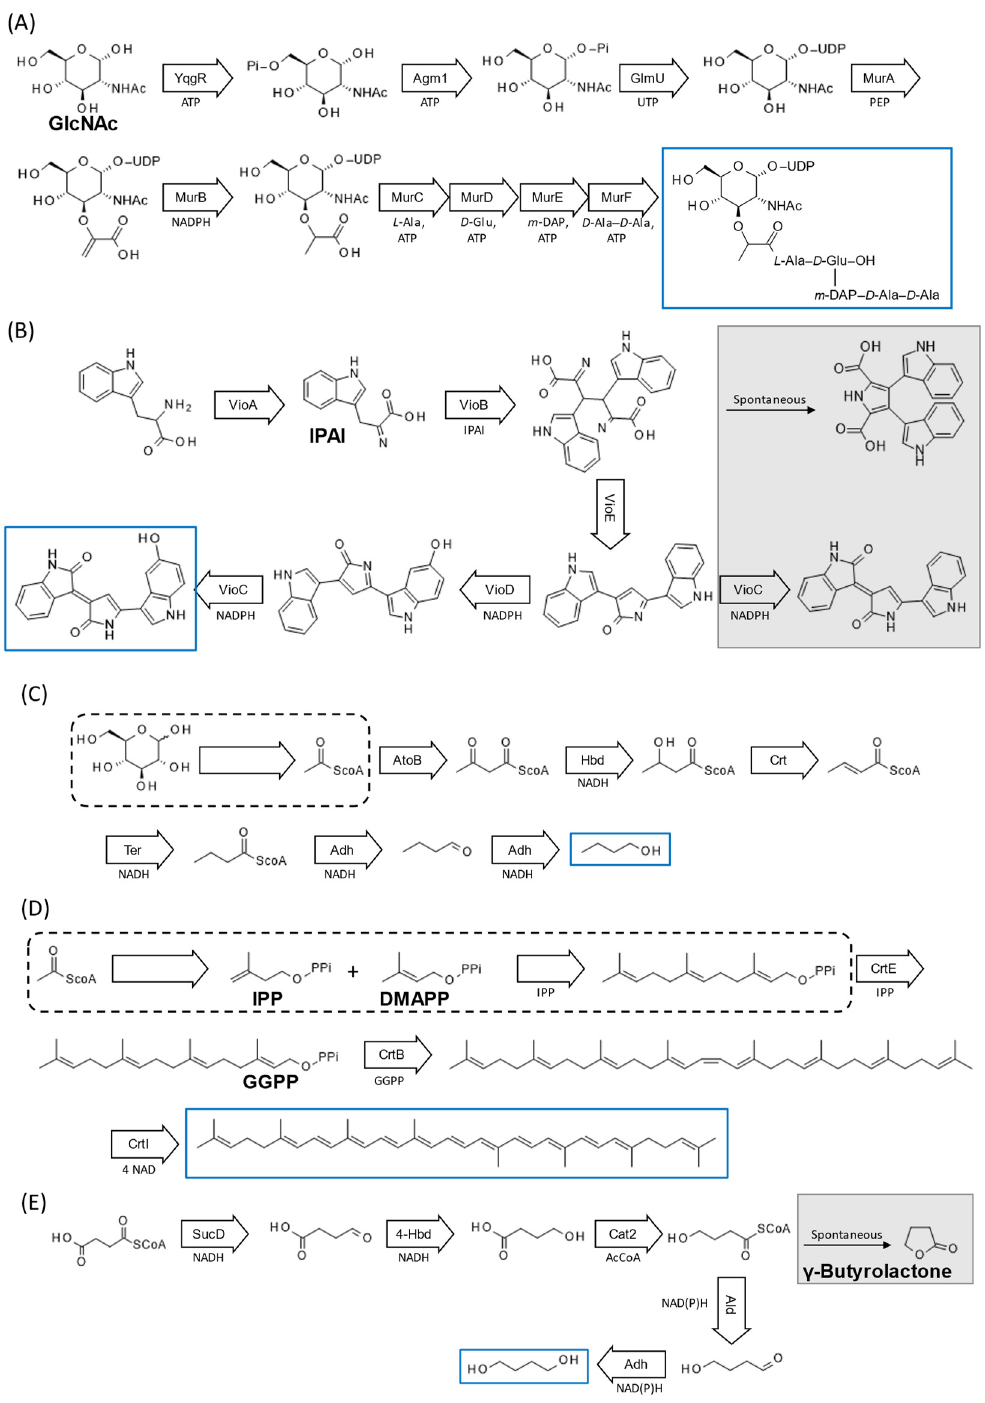
Figure 3. Metabolic pathways constructed by cell-free multiple gene expression. Single enzyme re- actions are presented as solid arrows, with the enzyme’s name inside, and multiple step reactions involving multiple enzymes are shown as broken arrows. Key substrates of each reaction are shown beneath the arrow. Desired end products of the constructed pathways are shown in blue boxes, while unwanted side products and related reactions are shown in grey boxes. For simplicity, not all names of the intermediates are described. ( A ) Schematic diagram of the synthesis of UDP-N-acetyl- muramyl pentapeptide from N-acetylglucosamine ( GlcNAc ). Pi, phosphate; PEP, phosphoenolpy- ruvate; m-DAP, meso-diaminopimelic acid. ( B ) Schematic diagram of a violacein biosynthetic path- way from tryptophan. IPAI, indole-3-pyrivic acid imine. ( C ) Schematic representation of a biosyn- thetic pathway to n -butanol from glucose using a hybrid pathway that consists of five cell-free ex- pressed enzymes (indicated by solid arrows) and endogenous glycolytic pathway enzymes (shown in a box with a dashed line). ( D ) Schematic representation of a lycopene biosynthesis pathway from acetyl-CoA. The endogenous metabolic pathway, including the mevalonate pathway, is shown in a box with a dashed line. IPP, isopentenyl pyrophosphate; DMAPP, dimethylallyl diphosphate; GGPP, geranylgeranyl pyrophosphate. ( E ) The biosynthetic pathway to 1,4-butanediol (BDO) syn- thesis from succinyl-CoA. AcCoA, acetyl-CoA. 4.2. Expression Levels of Multiple Genes Can Be Modulated by Controlling the Template Concentrations Even though they constitute a single enzymatic step rather than a metabolic pathway, the co-expression of PhaC and PhaE of Synechocystis sp. PCC 6803 in a CFPS system is intriguing [94]. PhaC and PhaE are subunits of a type III polyhydroxyalkanoate (PHA) synthase PhaCE, which polymerizes ( R )-3-hydroxybutyrate [95] and is analogous to Cu- priavidus necator (formerly Ralstonia eutropha ) PhaC, a type I PHA synthase. In an attempt to form an active PHA synthase, Numata et al. [94] first produced PhaC and PhaE indi- vidually in an E. coli CFPS system, and then purified them and reconstituted the purified subunits in varying molar ratios. However, none of the tests resulted in measurable PHA synthase activity. One result of note is that the yields of PhaC and PhaE were 7.8 and 61 mg/L, respectively. Since the molecular weights of PhaC and PhaE are similar [95], it is obvious that the expression of PhaE is more efficient than that of PhaC when a similar concentration of templates is used to prime CFPS. The authors next tried to coproduce the